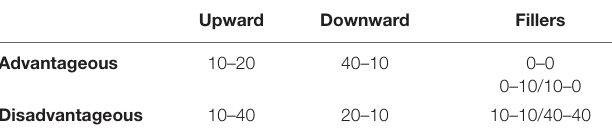
TABLE 1 | Reward conditions in the